Question: Which visualization type does this figure use?
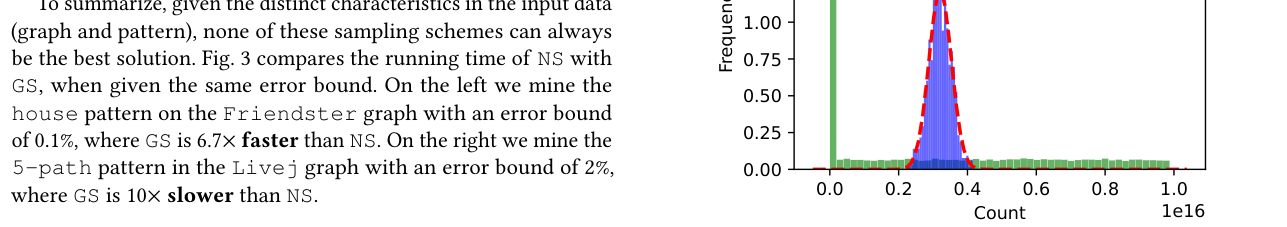
Answer: bar